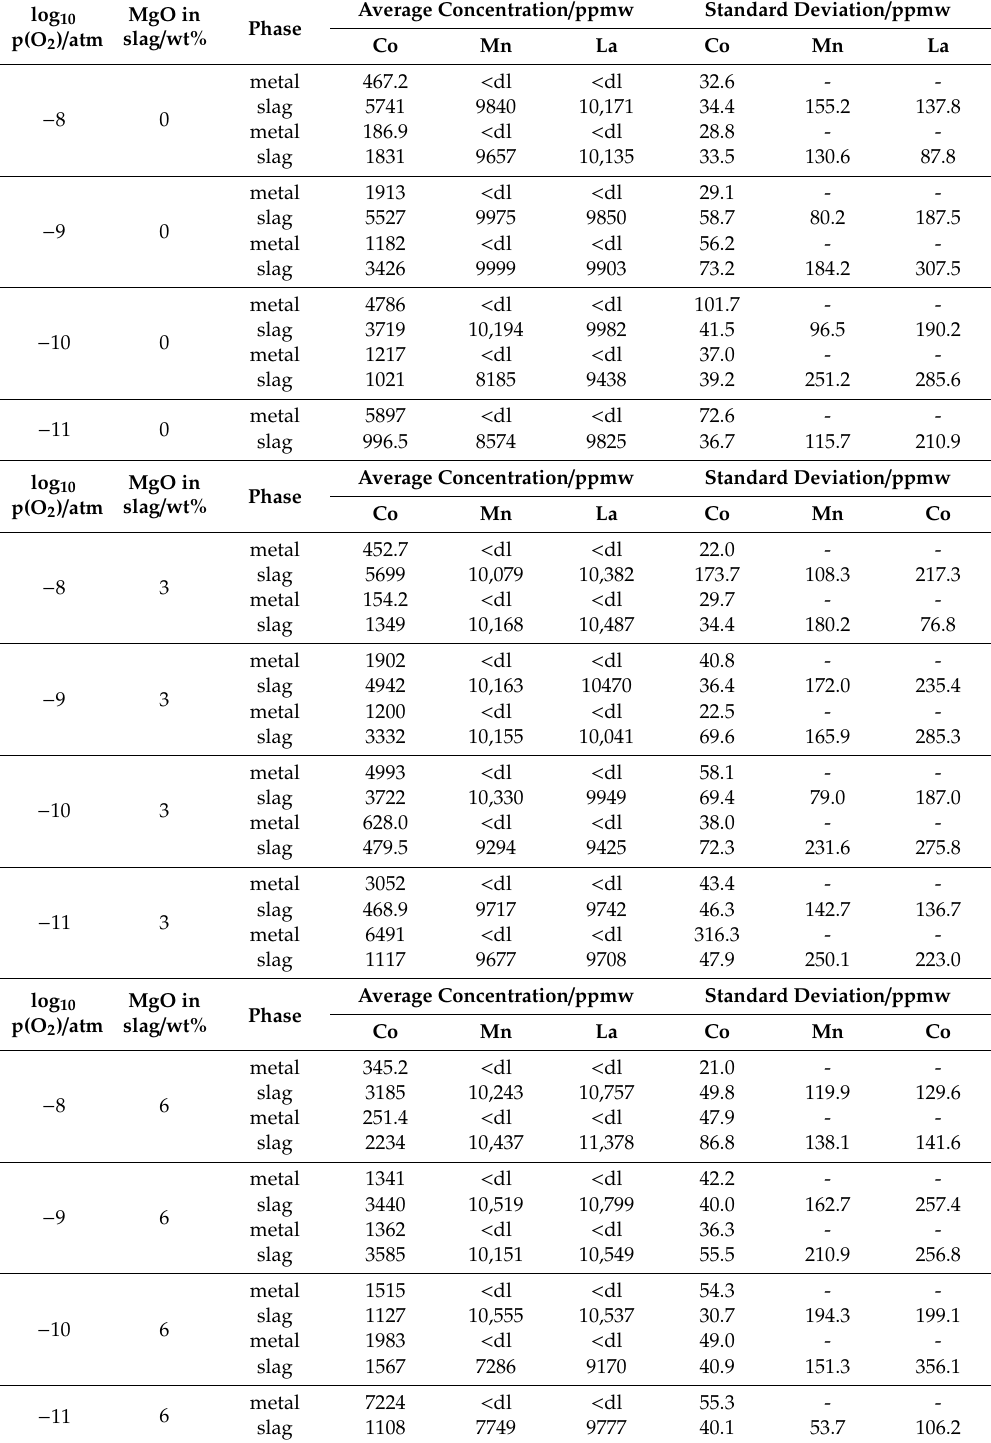
Table A1. Concentration of Co, Mn, and La in metal and slag phases, based on EPMA analyses. MgO in log 10 slag / p(O 2 ) / atm